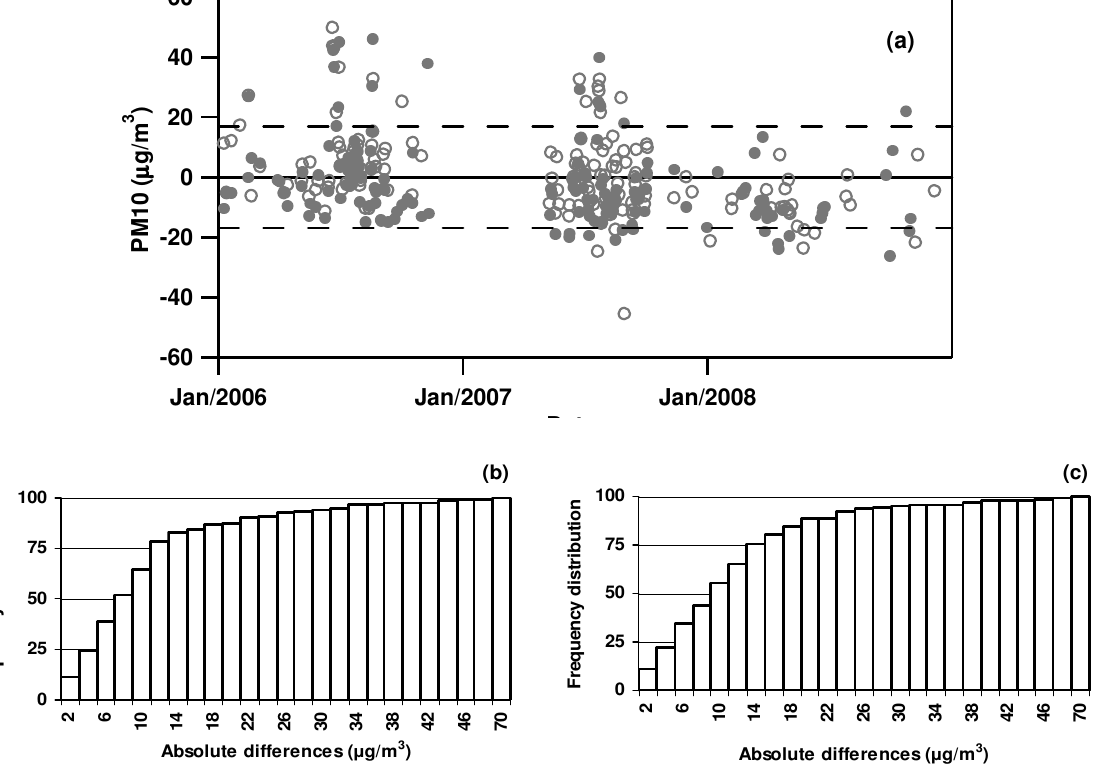
Figure 17. (a) Differences between measured and estimated PM10 mass concentrations in accordance with Equation (2) for Arnesano (open dots) and Guagnano (full dots) in 2006, 2007, and 2008. Dotted lines represent ±1 SD deviation of PM10 mass concentration yearly means. Cumulative frequency distribution of absolute differences at (b) Arnesano and (c)